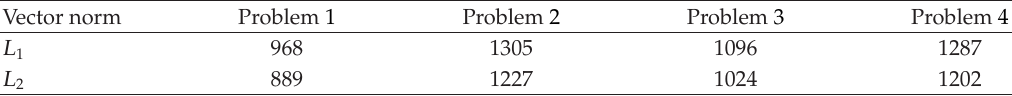
Table 11: The e ff ect of the vector norm on the convergence speed of the CGA. Vector norm Problem 1 Problem